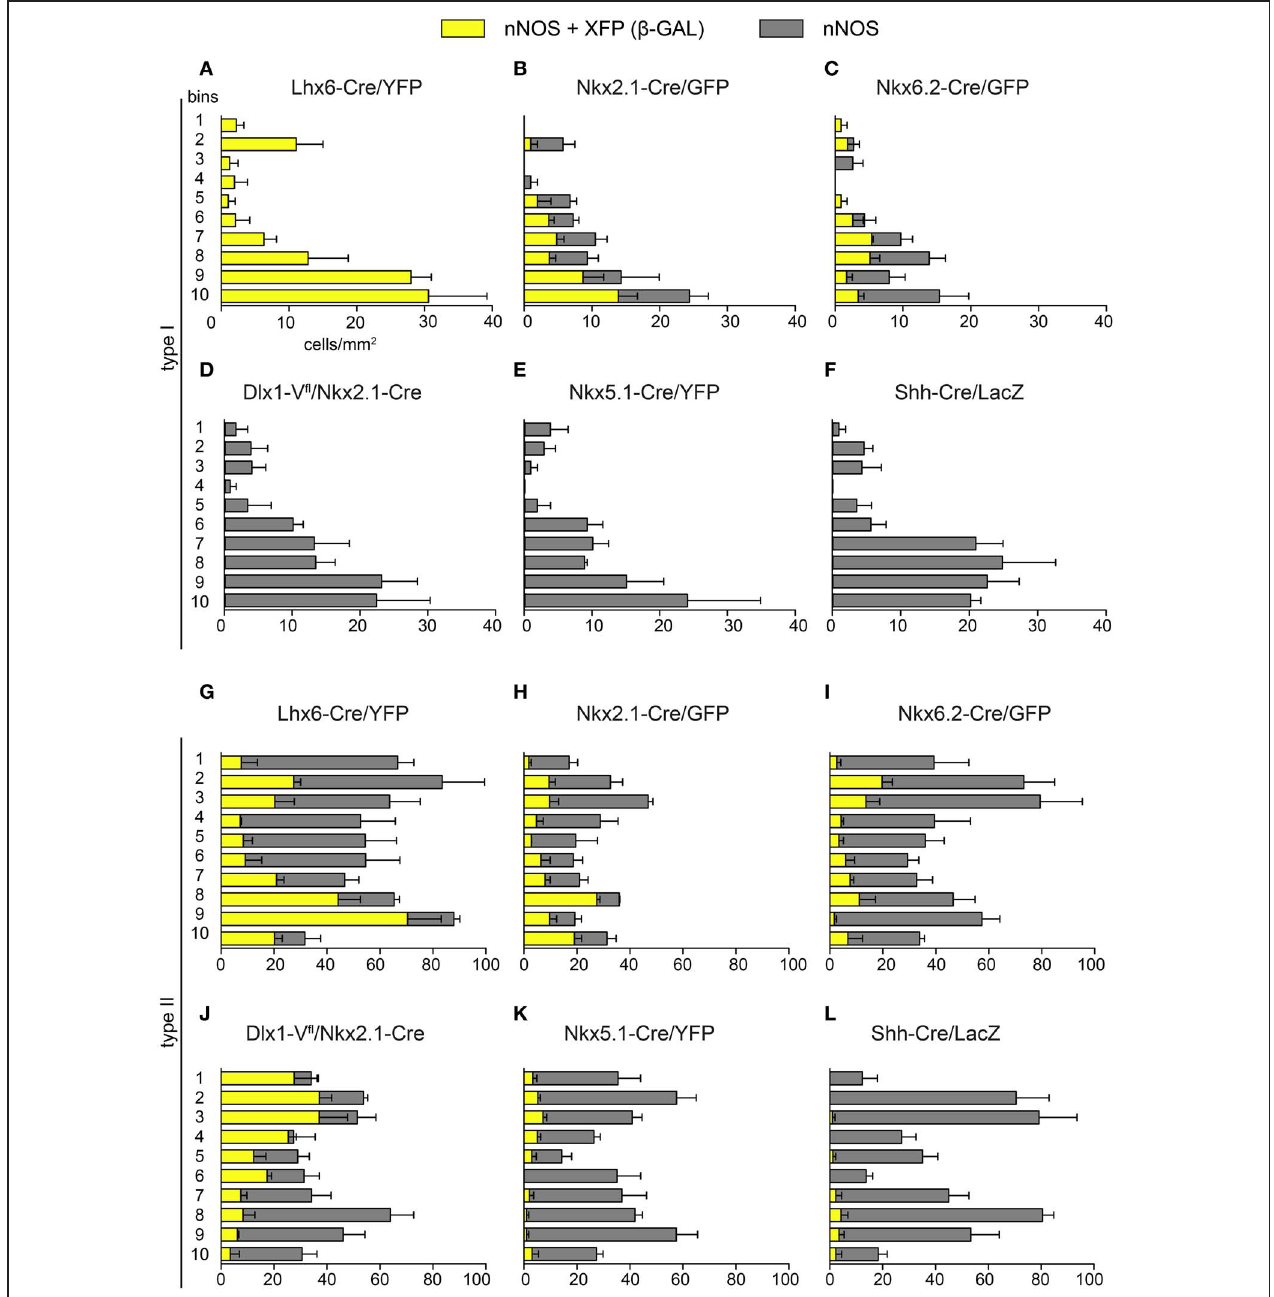
FIGURE 6 | Laminar distribution of nNOS immunoreactive cells originating in different embryonic neuroepithelial regions. The density of type I (A–F) and type II cells (G–L) coexpressing GFP/YFP/Venus/ β -gal (yellow) as well as the total number of nNOS-expressing cells (gray) across cortical bins are shown for each transgenic mouse line. Error bars indicate